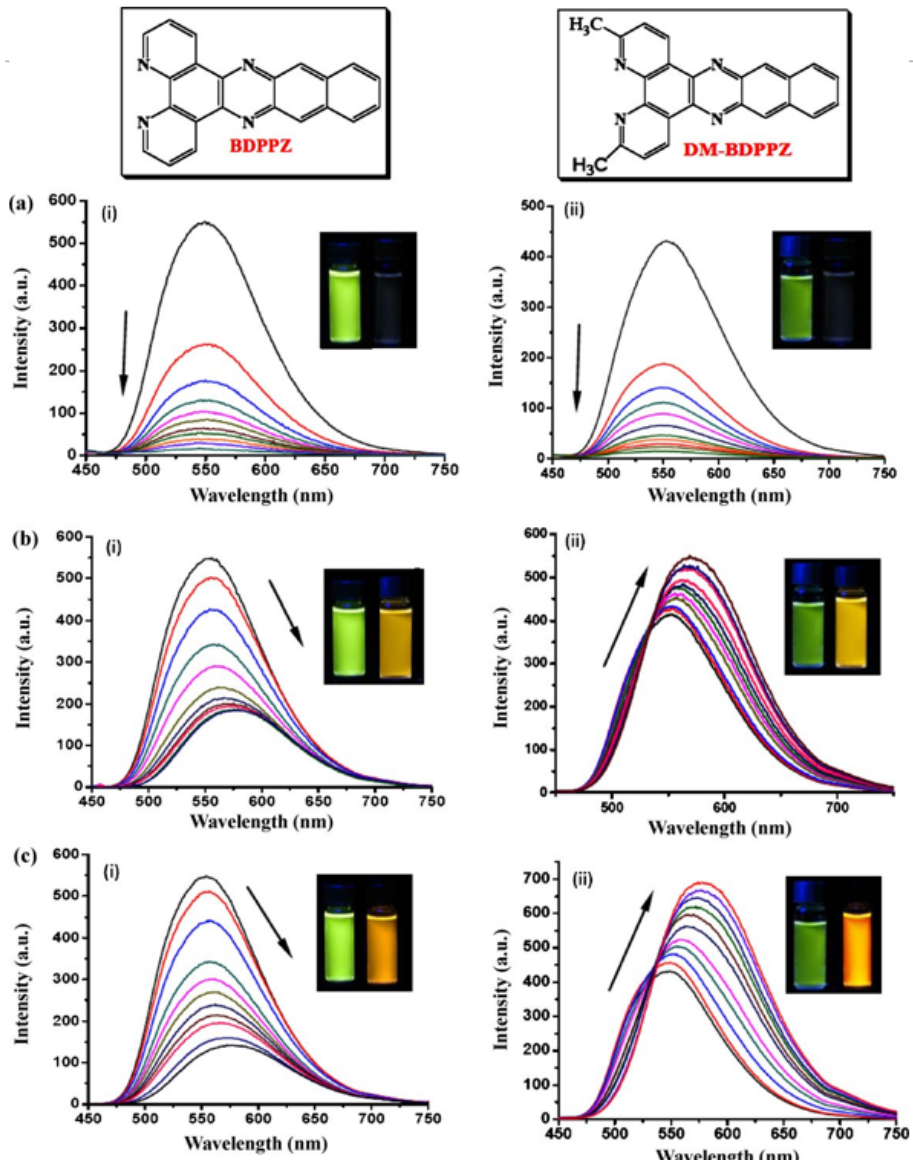
Figure 8. The fluorescence spectra changes of (i) benzodipyrido [3,2-a:2*,3*-c] phenazine (BDPPZ) (ii) 3,6-dimethylbenzodipyrido-[3,2-a:2*,3*-c] phenazine (DM-BDPPZ) when bound to three different OPP pesticides, ( a ) fenthion, ( b ) malathion, and ( c ) ethion, respectively. The inserts show the corresponding color transformations with the direction of the arrow indicating concentrations of 0, 1, 2, 3, 4, 5, 6, 7, 8, 9, and 10 µM, respectively [114].